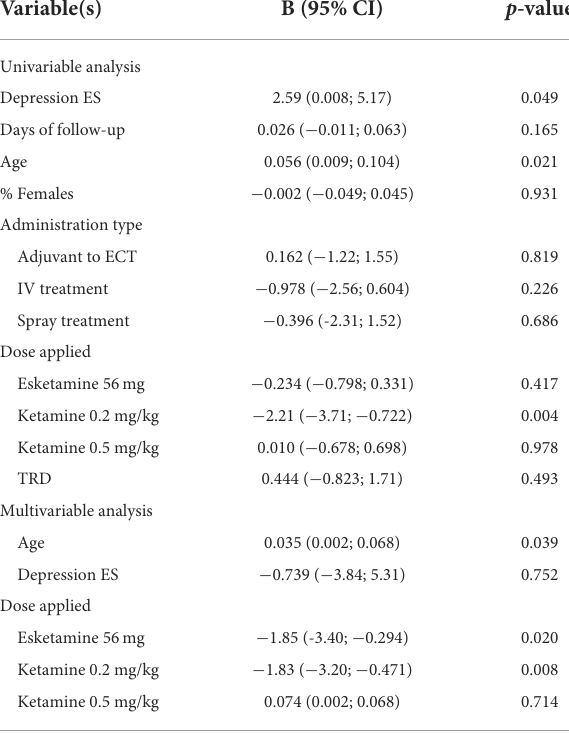
TABLE 2 Meta-regression on anxiety